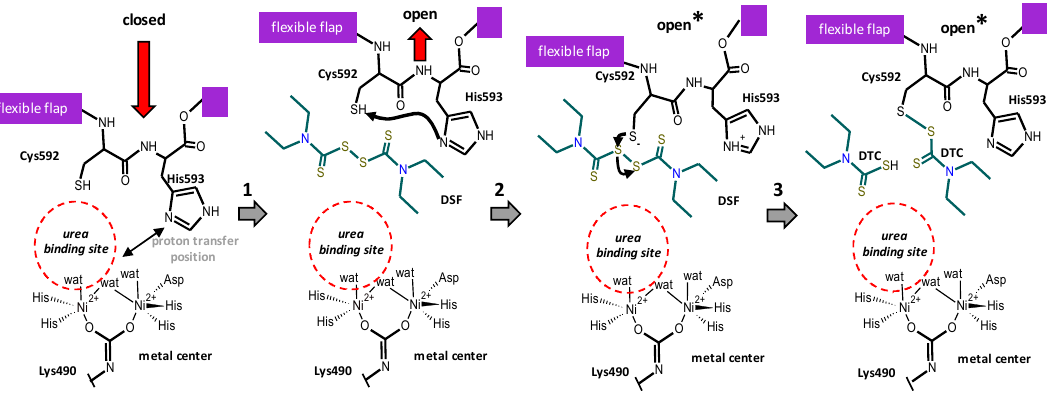
Figure 7. Scheme of the proposed chemical mechanism for the inhibition of urease enzymes by disulfiram: Empty urease is able to be in the closed or open conformation; (1) DSF binds to CVU in the open conformation and (2) Cys592 thiolate produces the attack to the thiuram group; (3) the enzyme is then modified by DTC moiety and block the flap to achieve the closed conformation; finally, the other DTC moiety is released from the enzyme. Chemical structures were drawn using ACD/ChemSketch ® .